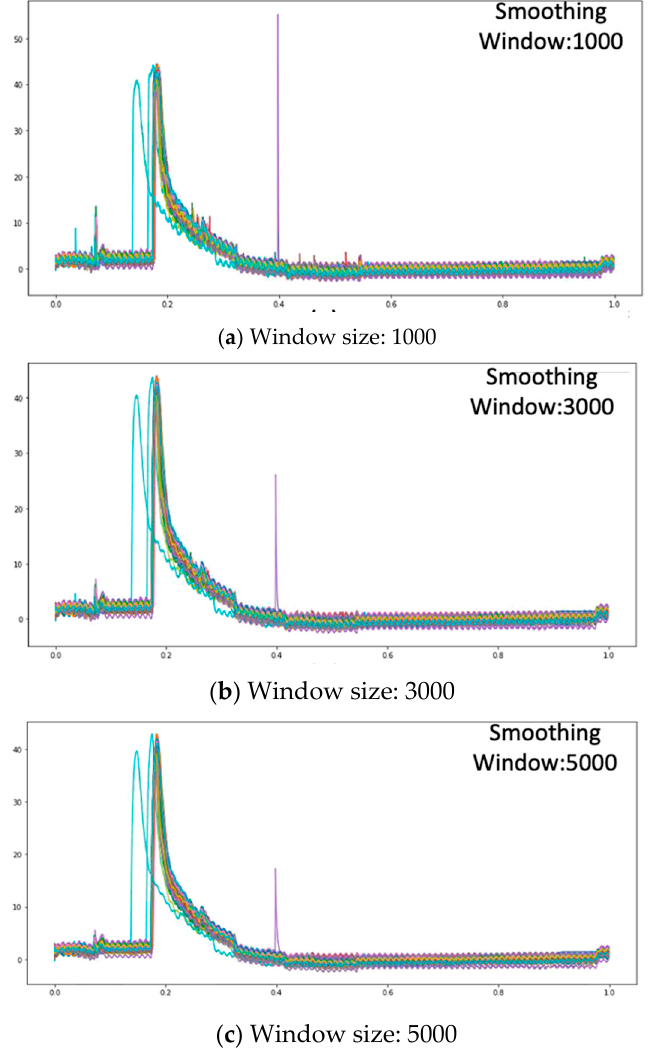
Figure 13. Comparison of EWMA smoothing effect by different window size.